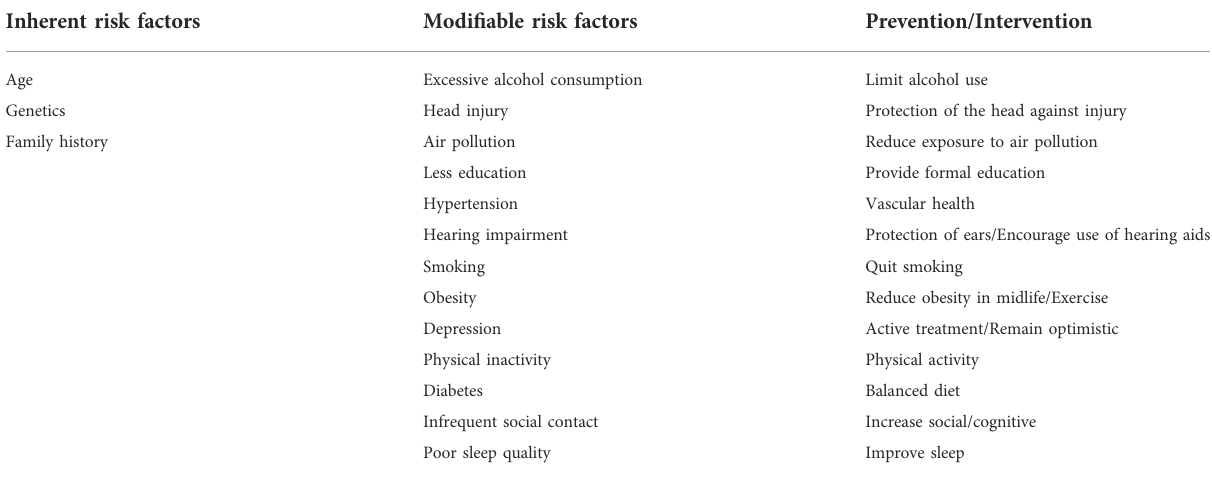
TABLE 1 Latest Risk factors and preventive measures for Alzheimer ’ s disease. Risk of Alzheimer ’ s disease Inherent risk